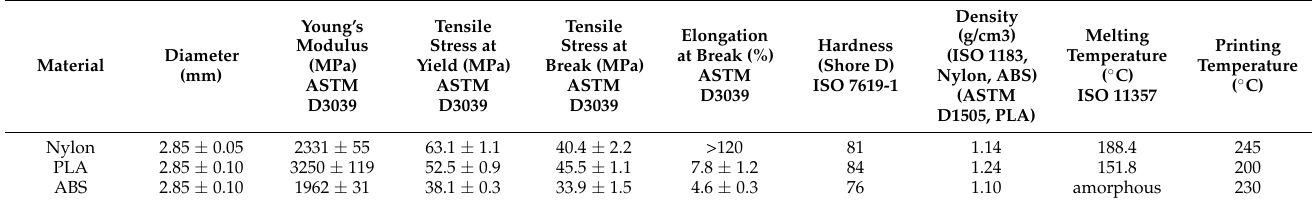
Table 1. Mechanical and physical property values of thermoplastic-filament materials.